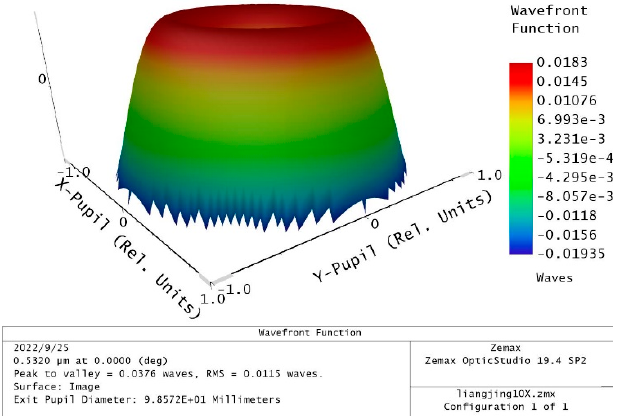
Figure 9. Schematic of the system wavefront of the laser beam expander. Table 5. Monte Carlo analysis results of the laser beam expander.